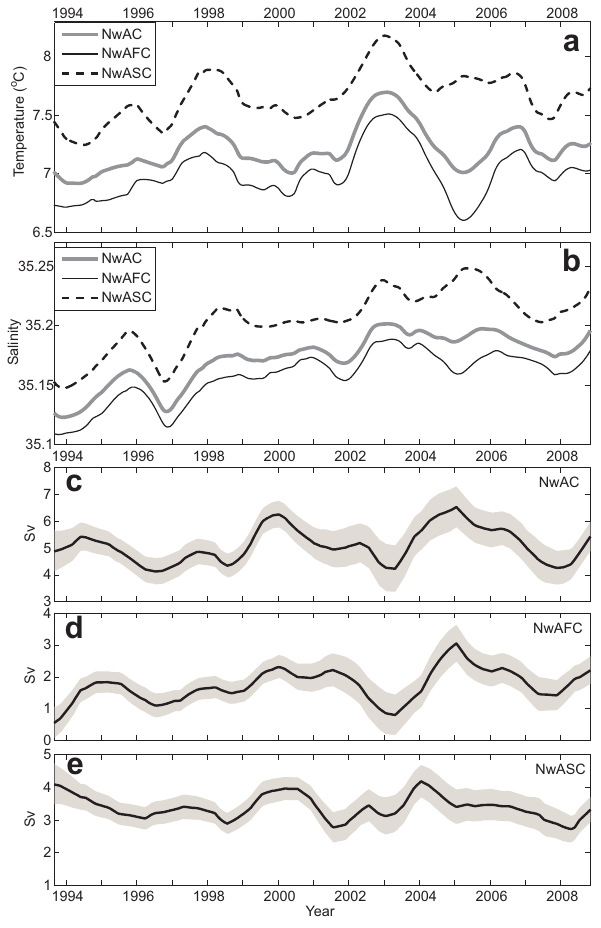
Fig. 7. Time series of temperature (a) , salinity (b) , and volume fluxes (c–e) for the NwAC, NwAFC and NwASC. Shades areas in volume fluxes are standard error estimates. All time series are one year moving